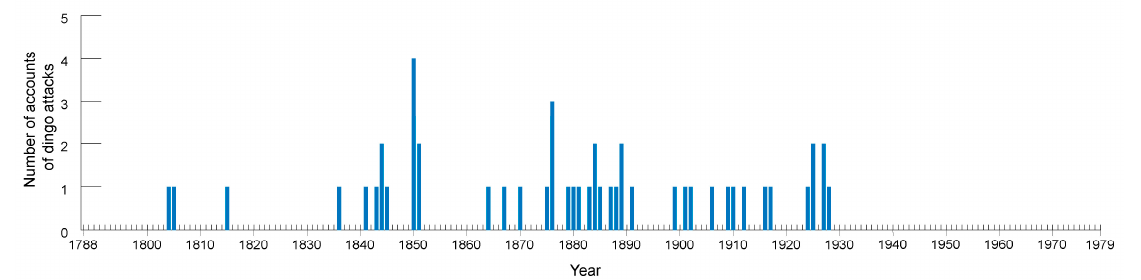
Figure 3. Distribution of historical accounts of dingo attacks ( n = 52) in mainland Australia by year.